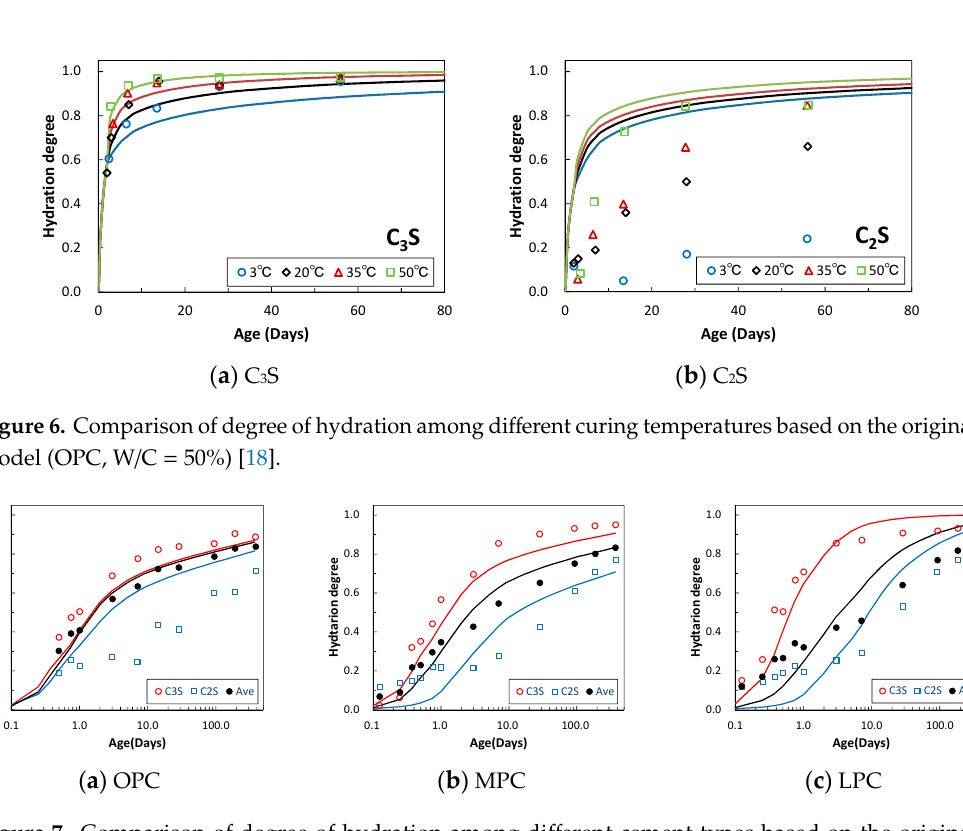
Figure 7. Comparison of degree of hydration among different cement types based on the original model (W/C40%, Seal-cured at 20 °C) [20].